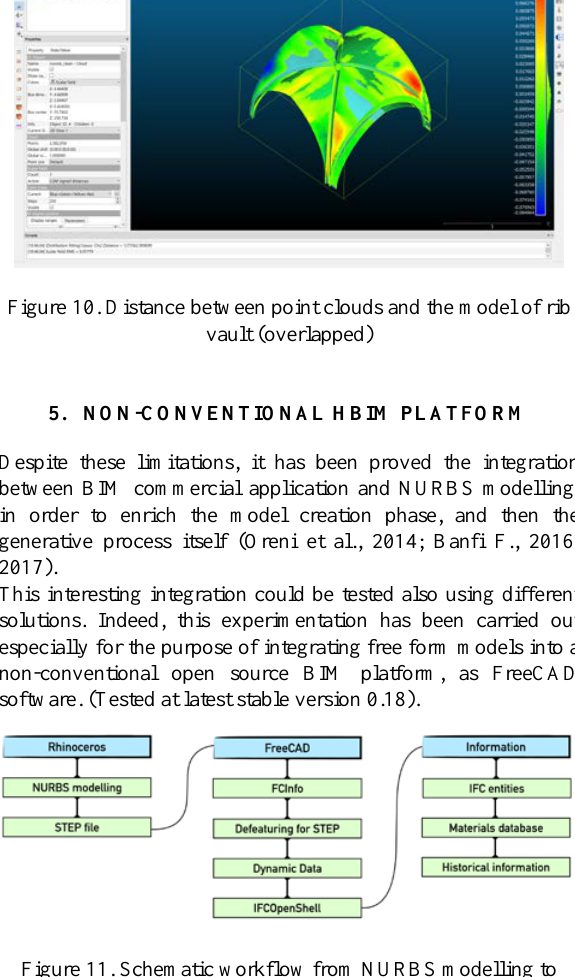
Figure 11. Schematic workflow from NURBS modelling to open source